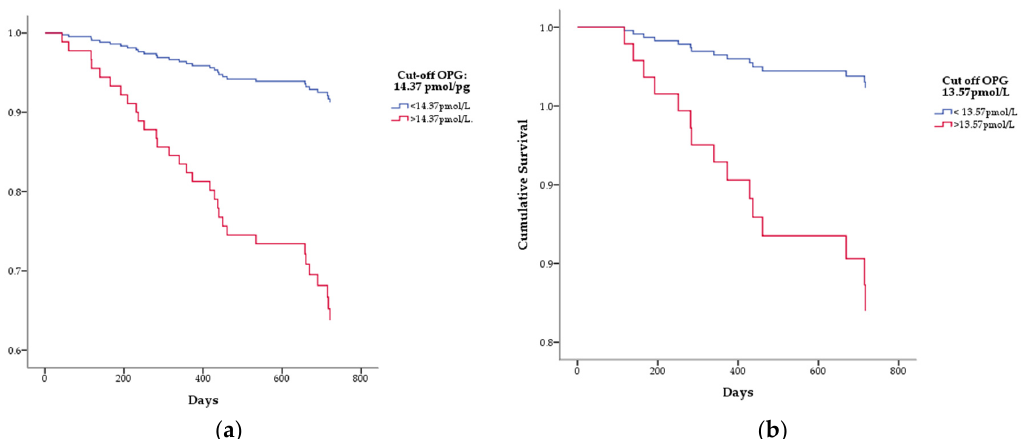
Figure 3. ( a ) All-cause survival analysis (Cox regression) according to the cut-off point for osteopro- tegerin (14.37 pmol/L), p < 0.001. ( b ) Cardiovascular survival analysis (Cox regression) according to the cut-off point for osteoprotegerin (13.57 pmol/L), p < 0.006.